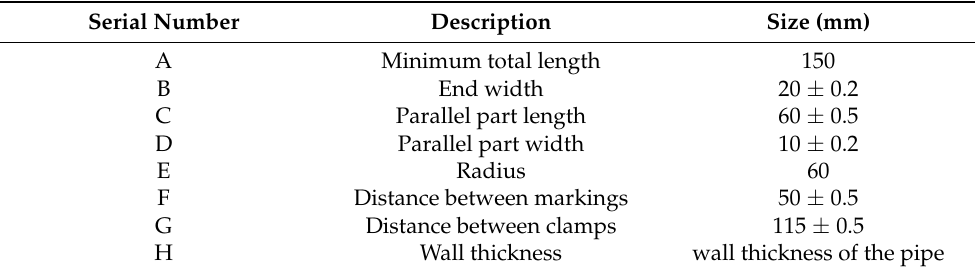
Figure 1. Sample size. Table 1. Sample size description.